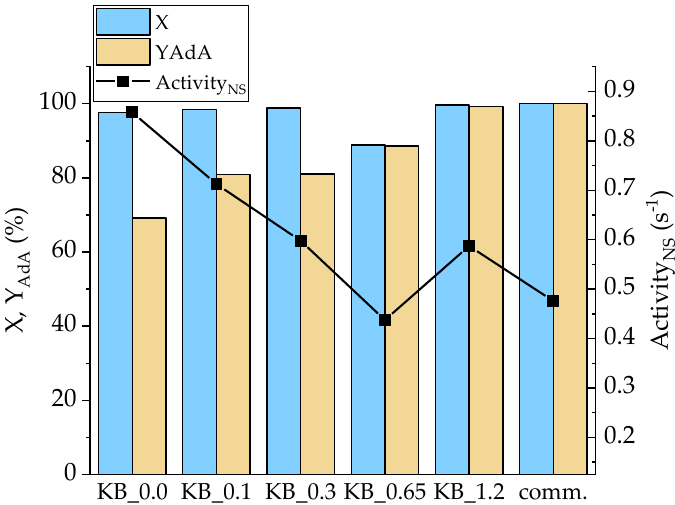
Figure 7. Conversion (X) and YAdA after 90 min of reaction and activity NS after 15 min for Na-Muc hydrogenation.